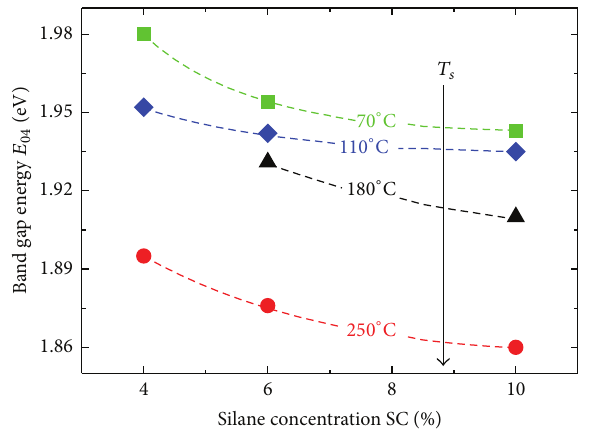
Figure 3: 𝐸 04 band gap as a function of silane concentrations for a-Si:H layers deposited at different substrate temperatures 𝑇 𝑠 . The dotted lines are to guide the